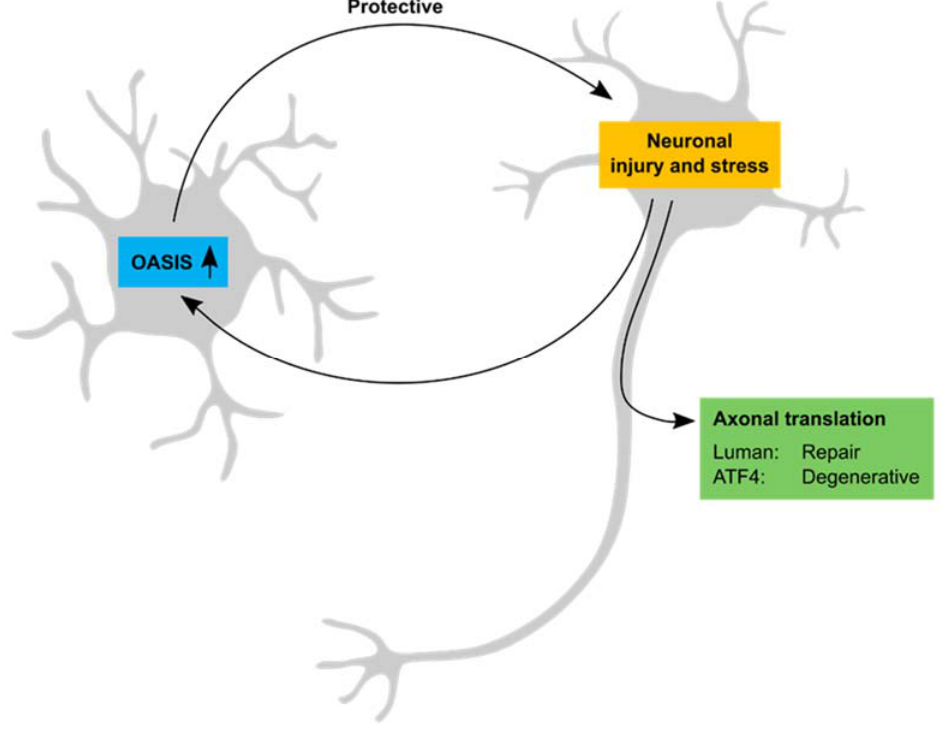
Figure 2. Potential interaction of cell ‐ type ‐ specific UPR responses in neuronal stress and injury. Neuronal stress (i.e., kainate or A β toxicity) or injury (i.e., axotomy) induces the UPR in glia cells and neurons. In addition to the canonical UPR present in every cell, cell ‐ type ‐ specific and cell non ‐ autonomous signaling are activated. The astrocyte ‐ specific UPR transducer OASIS elicits both a cell autonomous and cell non ‐ autonomous protective response. In the neuronal axon, the